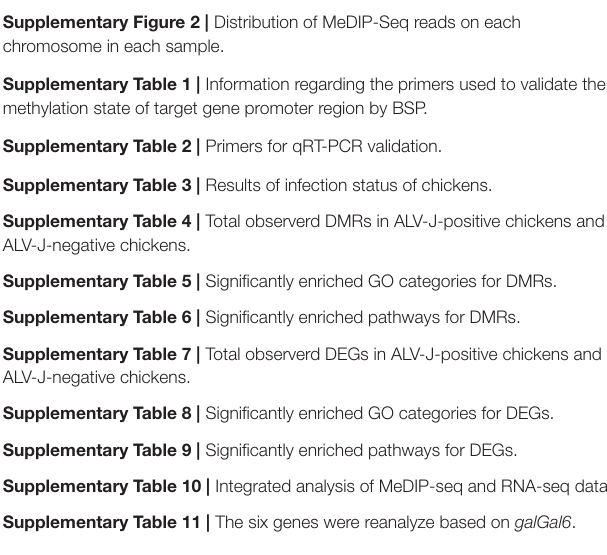
Supplementary Figure 1 | Quality assessment of RNA-Seq library. Supplementary Figure 2 | Distribution of MeDIP-Seq reads on each chromosome in each sample.